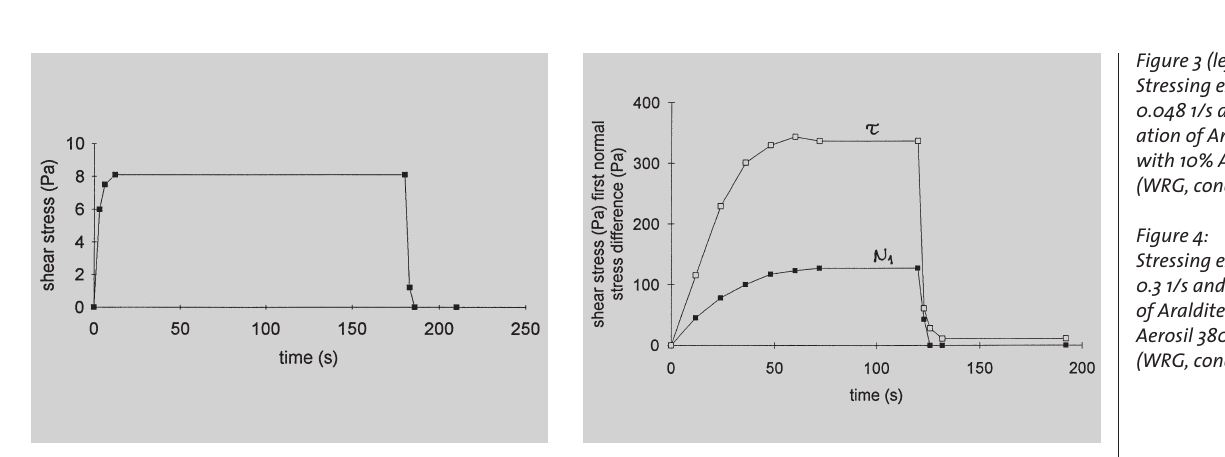
Figure 3 (left): Stressing experiment with 0.048 1/s and stress relax- ation of Araldite GY 260 with 10% Aerosil 380 (WRG, cone-plate 6°, 25°C). Figure 4: Stressing experiment with 0.3 1/s and stress relaxation of Araldite GY 260 with 10% Aerosil 380 (WRG, cone-plate 6°, 25°C).